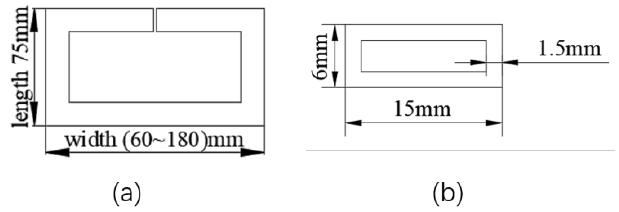
Figure 12. The shape of the inductor: ( a ) main dimensions of the coil; ( b ) cross section of the coil.